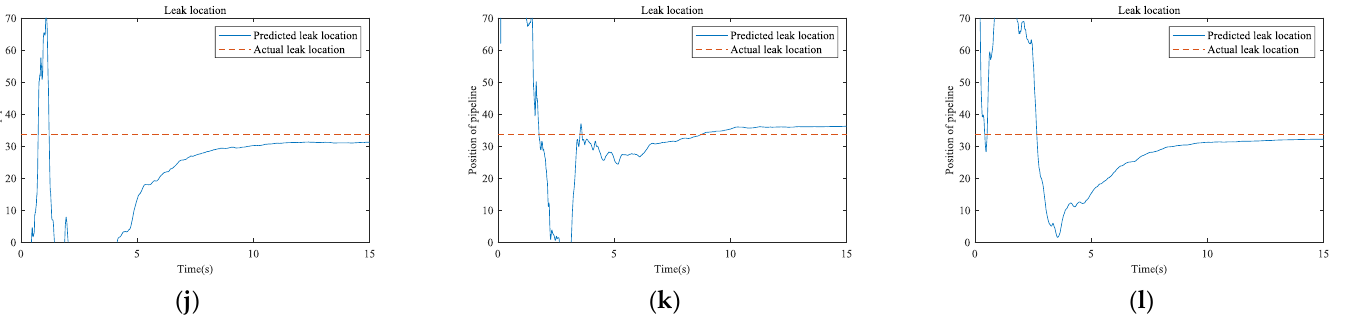
Figure 11. The result of leakage location. ( a – c ) Leak point 1, leak size: large; ( d – f ) leak point 1, leak size: small; ( g – i ) leak point 2, leak size: large; ( j – l ) leak point 2, leak size: small.